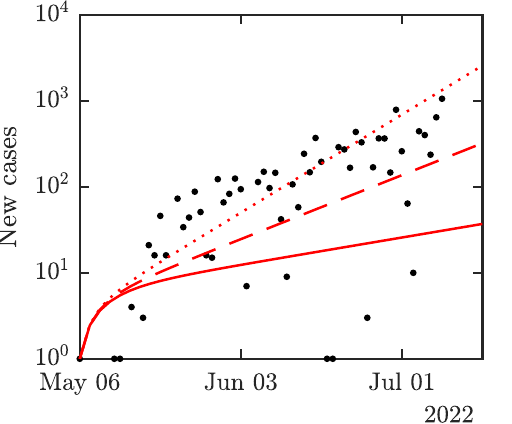
Fig 3. Actual (black dots) and predicted incidence. Full red line is for β = 0.09, dashed is for β = 0.19 and dotted is for β = 0.29. All other parameters are as specified in Table 1.